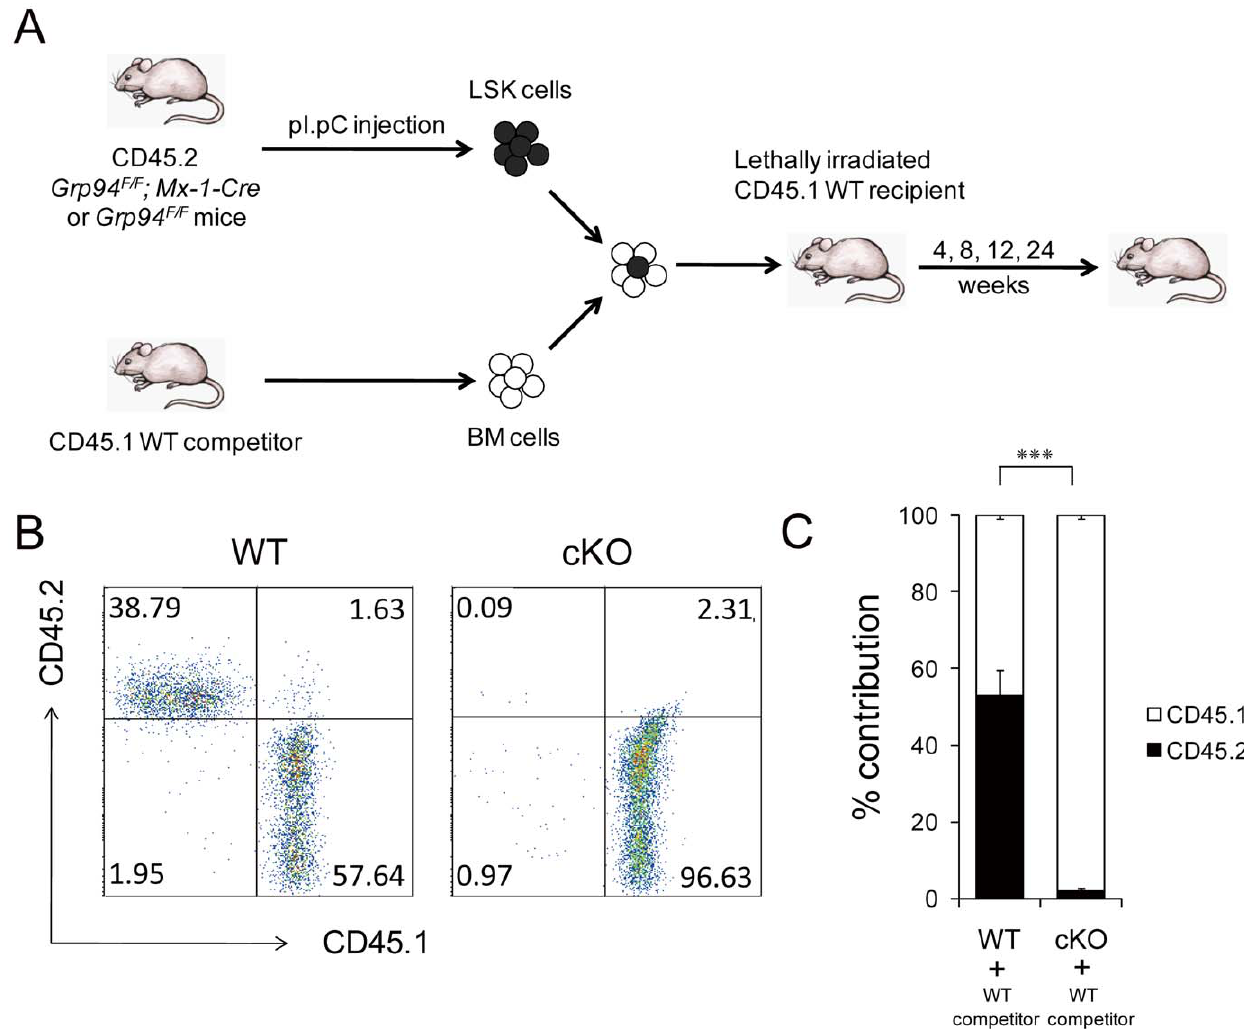
Figure 8. Grp94 KO HSCs failed to reconstitute the hematopoietic system in the presence of WT competitors. A) Scheme of the in vivo competitive repopulation assay. B) Representative flow cytometric analysis with tail blood from recipient mice 4 weeks after BM transplantation. CD45.1 + cells represent blood cells from WT competitor, while CD45.2 + cells represent progenies from WT or cKO LSK cells. Tail blood from recipient mice 8, 12, and 24 weeks after BM transplantation yielded the same results (data not shown). C) Summary of the percentage contribution of WT or cKO LSK cells to the peripheral blood MNCs (n=5). The data are presented as mean 6 s.e., ***p , 0.001.